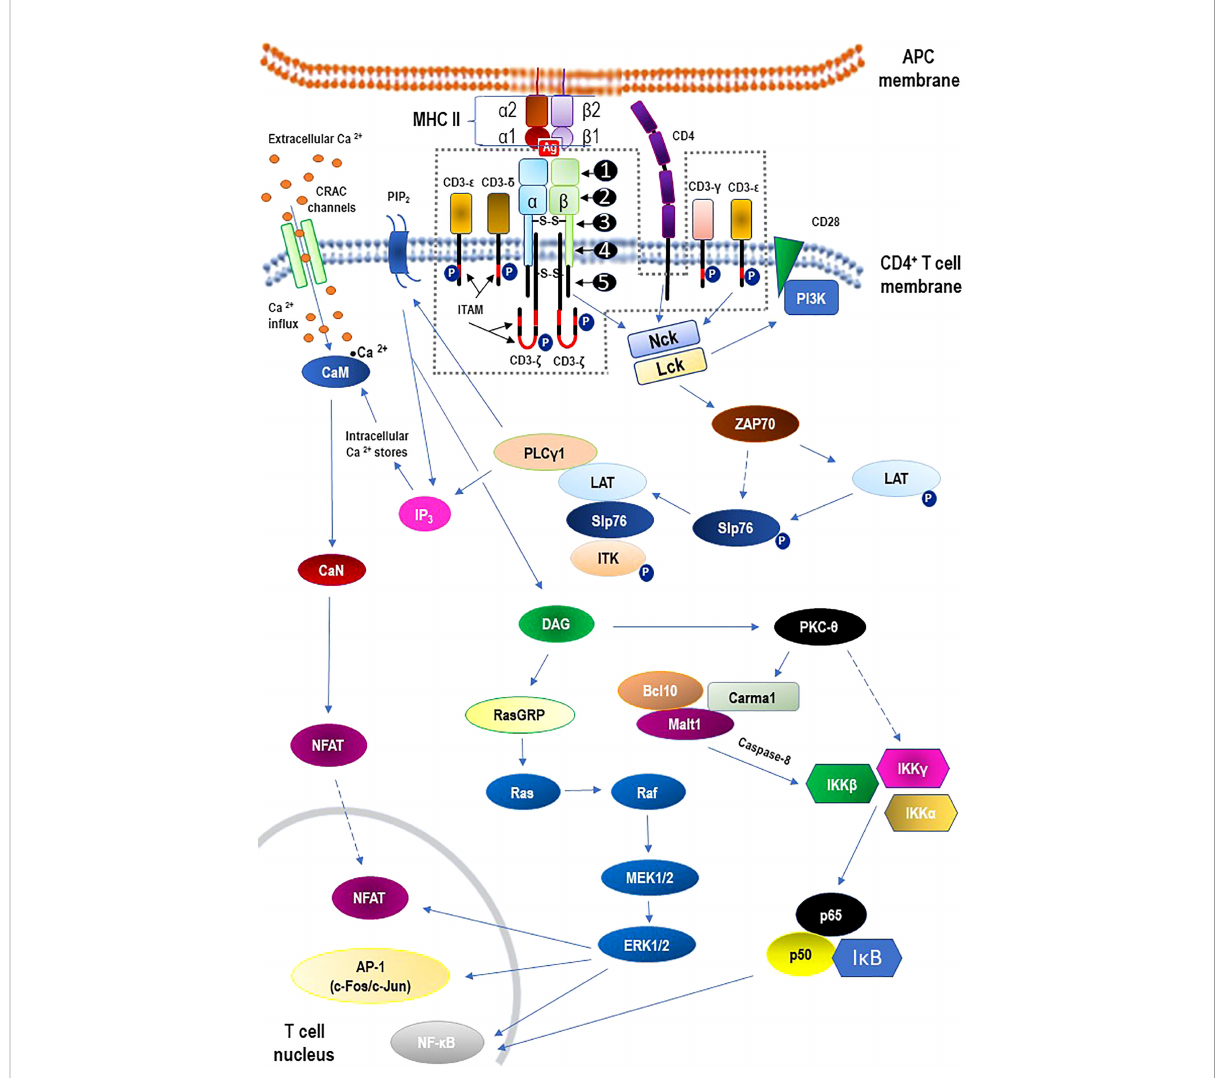
FIGURE 2 Structure of the ab Tcell receptor(TCR)andthe TCR-CD3complex (the areawithinthedashedline)includingmainsignalingpathways. -TCRstructure: ❶ - variableregion; ❷ - constantregion; ❸ -hingeregion; ❹ -transmembraneregion; ❺ - cytoplasmatictail.- ThecoreTCRsignalingcomplex consists of twoTCRchains( ab heterodimer)thatarenoncovalentlycoupledtothree dimericsignalingmolecules namedtheclusterof differentiation3(CD3):CD3 ϵ d , CD3 ϵ g , andCD3 zz . - Signaling via theTCR/CD3antigenreceptorcomplex is activatedafterinteractionoftheTCRwith cognatepeptideantigenboundto a majorhistocompatibility complex (MHC)moleculeon thesurfaceofantigen-presentingcells(APC),andco-stimulationbyco-receptormoleculessuch asCD28.Anearly eventintheproximal signalingof TCR is theinvolvementandactivation of asetof proteintyrosinekinases(PTKs),suchasLCK, FYN, and ZAP-70, thatareimportantcomponentsrequiredforactivationofTCRsignalingthroughtyrosinephosphorylationonCD3. Theproximal TCR signaling is followedbythe activationof multipledistal signalingcascades, suchas: (cid:129) Ca 2+ – calmodulin (CaM) – calcineurin(CaN) – nuclearfactorofactivatedT-cells (NFAT); (cid:129) diacylglycerol(DAG) – Rasguanyl nucleotidereleasingprotein(RasGRP) – Ras – proto-oncogeneserine/threonine-protein kinase(Raf) – dual- speci fi city tyrosine/threonineproteinkinases(MEK1/2) – extracellularsignal-regulatedkinases1/2(ERK1/2); (cid:129) proteinkinase C-theta(PKC q ) – Ikappa B kinases(IKK a ,IKK b , IKK g ) – nuclearfactorkappaB(NF- k B). Thesesignalingcascades, regulatedlargely by epigeneticmechanisms, fi nallybringoutthe diversephenotypiceffects, as they control many aspectsof Tcell biology. Forthesakeofclarityofthediagram,thepresentationof thenegativeregulation (downregulation)ofTCR-mediatedsignalinghasbeenabandoned. Seethemain text(2.2. TCRsignaling)fordetails. a 1, a 2, b 1, b 2 – domains a 1and a 2 and b 1and b 2of thechains( a and b ,respectively)thatformheterodimericMHC-IIcomplex;Ag – antigen;AP-1 – activatorprotein1; Bcl10 – Bcell lymphoma 10;Ca 2+ – calcium; CaM – calmodulin;CaN – calcineurin;Carma1 – caspaserecruitmentdomainmembrane-associated guanylate kinaseprotein1;c- Fos/c-Jun – AP-1-formingdimerofproto-oncogenes;CRAC – calciumrelease-activatedCa 2+ ; DAG – diacylglycerol;I k B – kinase(IKK)complex containingIKK a , IKK b ,and IKK g ;IKK a – IkappaBkinase a ;IKK b – IkappaBkinase b ;IKK g – I kappaBkinase g ;IP 3 – inositol trisphosphate;ITAM – immunoreceptortyrosine-basedactivationmotif; ITK – interleukin-2inducible tyrosine kinase;LAT – linkeractivationofT cells;Lck – leukocyte-speci fi c tyrosine kinase;Malt1 – mucosa-associatedlymphoidtissueprotein1; Nck – adaptorproteinnon-catalyticregionof tyrosinekinase (Nck);NFAT – nuclear factorsof activatedT cells;NF- k B – nuclearfactorkappaB;P – phosphorylatedproteins;p50 – regulatorysubunit of theNF-kBcomplex;p65 – subunit of NF- k B;PI3K – phosphatidylinositol-3kinase;PIP2 – phosphatidylinositolbisphosphate;PKC-theta – protein kinaseC-theta;PLC g 1 – phospholipaseC gamma1;RasGRP – Rasguanyl nucleotidereleasingprotein; Slp76 – SH2-domaincontainingleukocyteproteinof 76 kDa;ZAP70 – zeta-activatedprotein